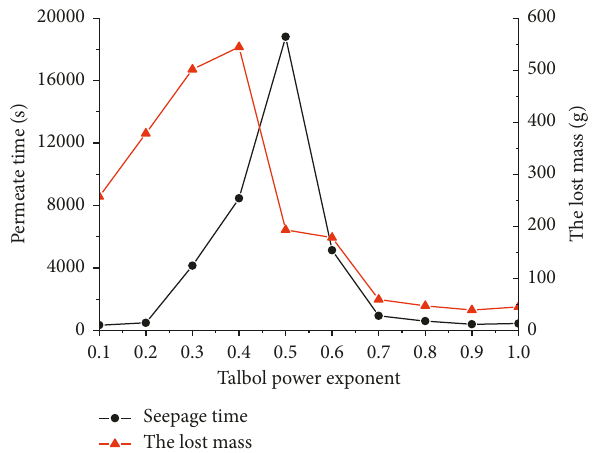
Figure 12: The permeate times and lost mass of different Talbol power exponents.